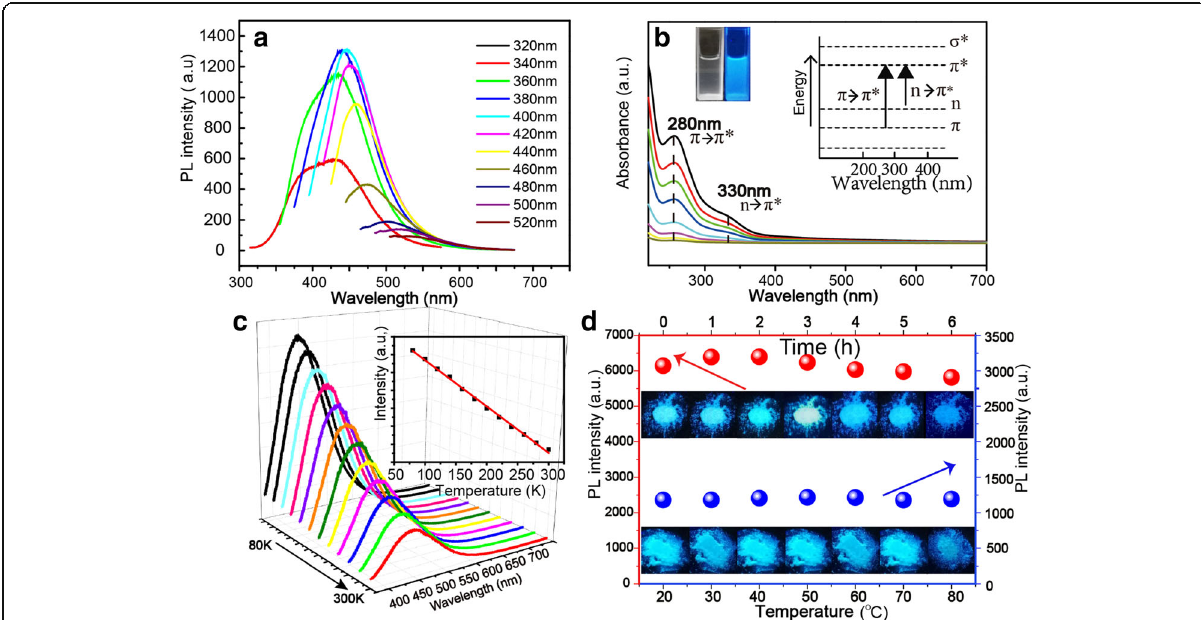
Fig. 3 a Fluorescence spectra of the NBDs with excitation wavelength changes from 320 to 520 nm. b UV-Vis absorption spectra of the NBDs. c Fluorescence spectra of the NBDs at different temperature, the inset is the plot of the fluorescence intensity of the NBDs as a function of temperature. d Fluorescence intensity and images of the NBD powders under the illumination of a 365-nm lamp for different duration and those of the NBD powders at different measuring temperature